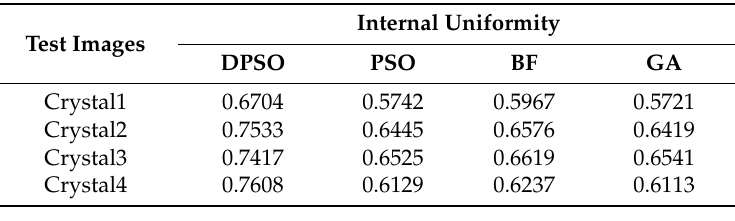
Table 8. Comparative analysis of internal uniformity obtained by the DPSO-based method with other bio-inspired multilevel methods.